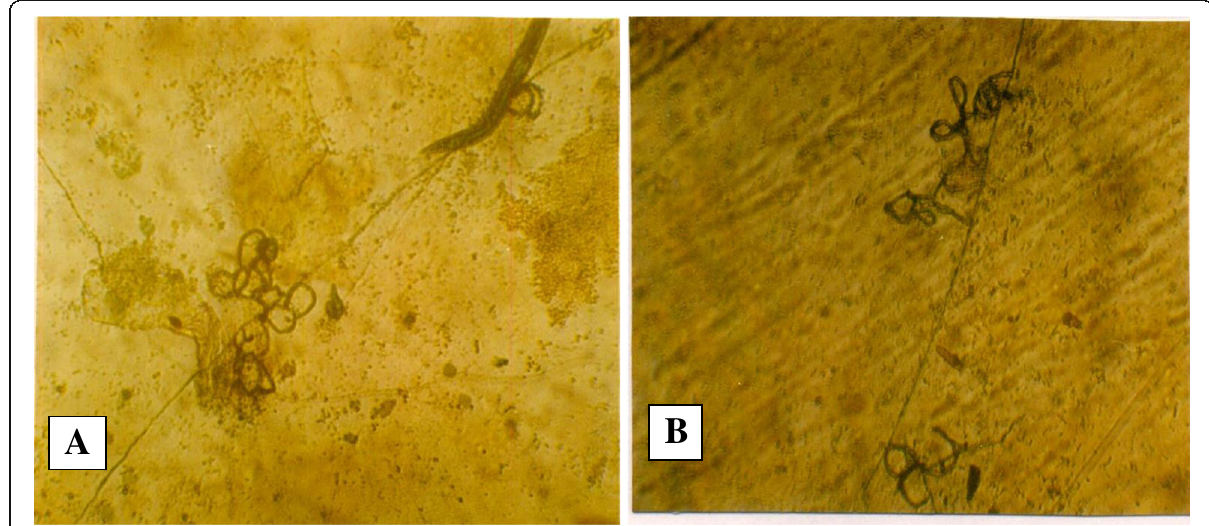
Fig. 1 Monacrosporium megalosporum . a A portion of hypha showing entangled nematode with adhesive net, the lower portion showing arched or circular hyphal meshes. b A portion of hypha with adhesive